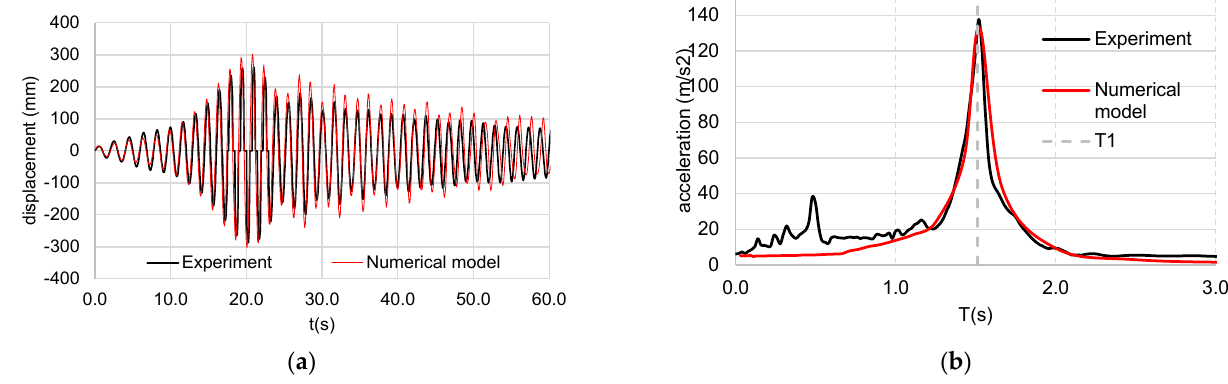
Figure 5. Fixed-base results for sine sweep excitation: ( a ) displacement of the top beam and ( b ) floor spectra.